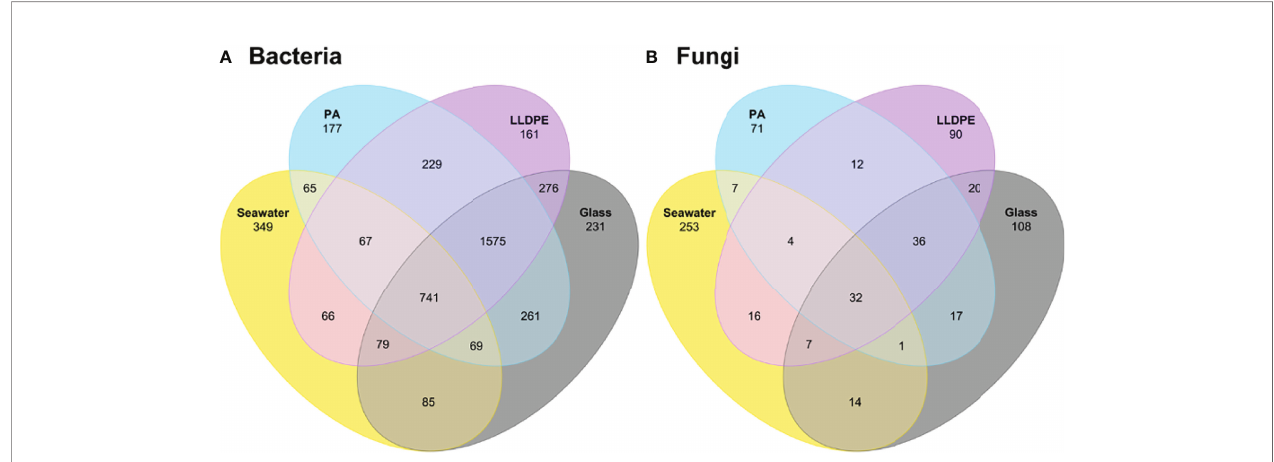
FIGURE 3 | Venn diagrams comparing the observed number of shared (A) bacterial and (B) fungal ASVs present in the surrounding seawater and on glass, nylon-6 (PA) or linear low-density polyethylene (LLDPE) in the marine environment of Te Whakaraup ō -Lyttelton Harbour, Aotearoa-New Zealand. Colours represent substrate type and numbers inside ellipses represent the number of shared